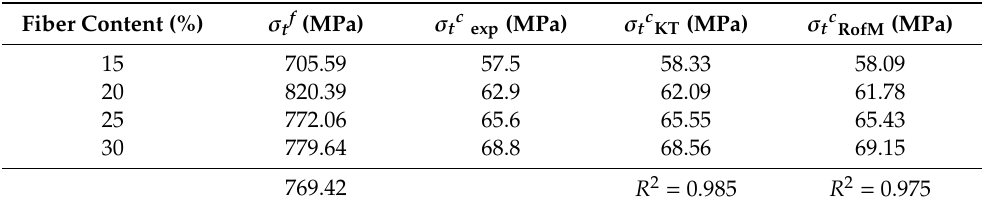
Comparison between experimental and back calculated tensile strengths of the composite materials.